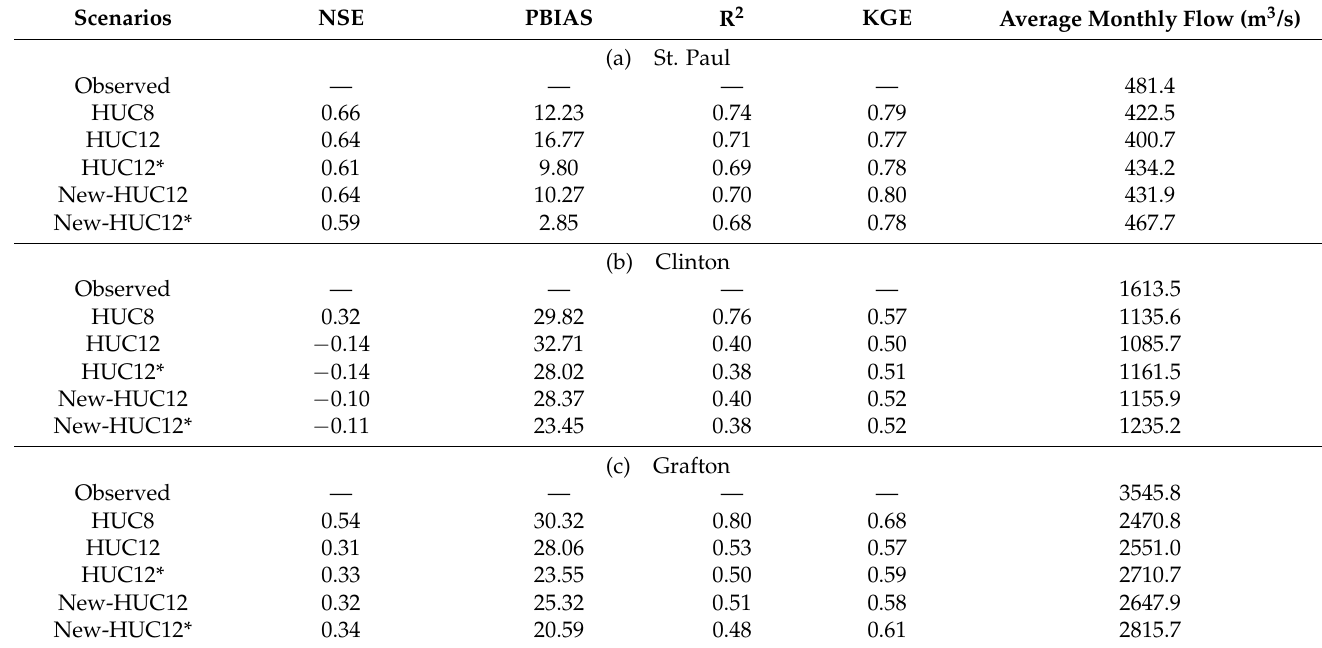
Table 6. Statistic evaluations and average monthly flow (m 3 /s) based on monthly flow for three gauge sites in different scenarios from 1983 to